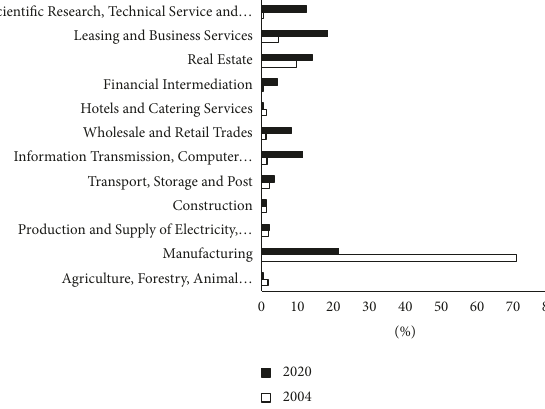
Figure 2: Distribution of China’s FDI in different industries.